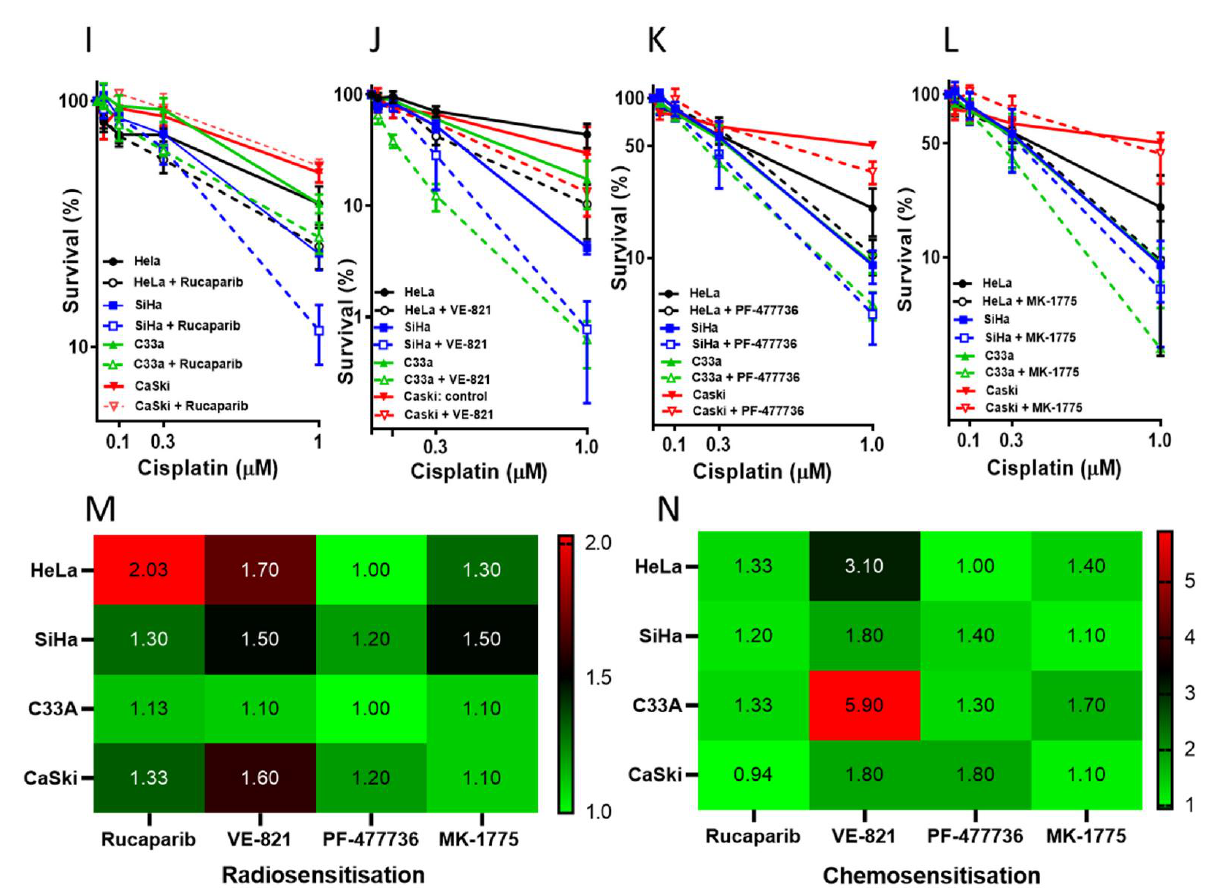
Figure 3. Single-agent cytotoxicity, radiosensitisation and chemosensitisation by the DDR inhibi- tors: Survival of cervical cancer cells following exposure to single agent ( A ) rucaparib, ( B ) VE-821, ( C ) PF-477736) and ( D ) MK-1775. Cells were exposed to increasing concentrations of the DDR in- hibitors for 24 hr and survival was determined by clonogenic assay. Survival is given as a percentage relative to the survival in 0.5% DMSO only as the control. Data are mean ± SEM from three inde- pendent experiments. Survival of cervical cancer cell lines exposed to increasing doses of ionising radiation (IR) ± ( E ) 1 μM rucaparib, ( F ) 1 μM VE -821, ( G ) 50 nM PF-477736, or ( H ) 100 nM MK-1775. Cells were exposed for 24 hr and survival was determined by clonogenic assay. Survival is normal- ised to vehicle (DMSO 0.5%) or inhibitor alone. Data represent means ± SEM from three independent experiments. Survival of cervical cancer cell lines exposed to increasing doses of cisplatin ± ( I ) 1 μM rucaparib, ( J ) 1 μM VE -821, ( K ) 50 nM PF-477736, or ( L )100 nM MK-1775. Cells were exposed for 24 hr and survival was determined by clonogenic assay. Survival is normalised to vehicle (DMSO 0.5%) or inhibitor alone. Data represents means ± SEM from three independent experiments. ( M ) The heatmap represents the radiosensitsation potency of the inhibitors, which is based on the PF50 (Sup- plementary Table S5) with the PF50 values given within each cells of the heatmap. ( N ) The heatmap represents the chemosensitsation potency of the inhibitors, which is based on the PF50 (Supplemen- tary Table S6) with the PF50 values given within each cells of the heatmap. The cells displayed a relatively narrow spectrum of sensitivity to both IR (LD50 in the range 1 – 2.5 Gy) and cisplatin (LC50 range 400 – 800 nM) (Supplementary Figure S6). HeLa cells, which have high levels of DNA-PKcs, Ku70 and Ku80 (Figure 1B) was the most radio-resistant cell line, but it was also resistant to cisplatin and therefore this may merely reflect a greater resistance to DNA damage-induced cell death in this cell line.